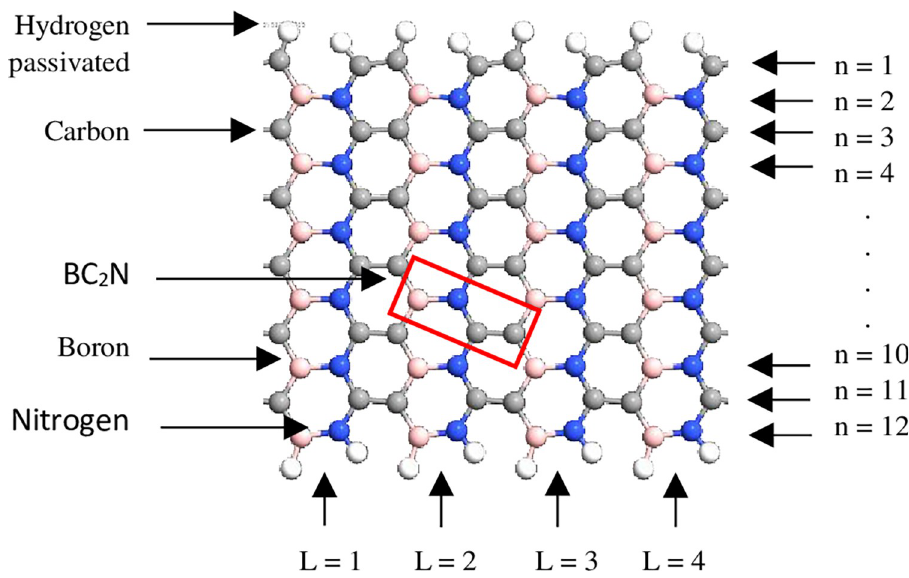
Fig 1. Optimized structure of the pristine A-BC 2 NNR with n = 12.